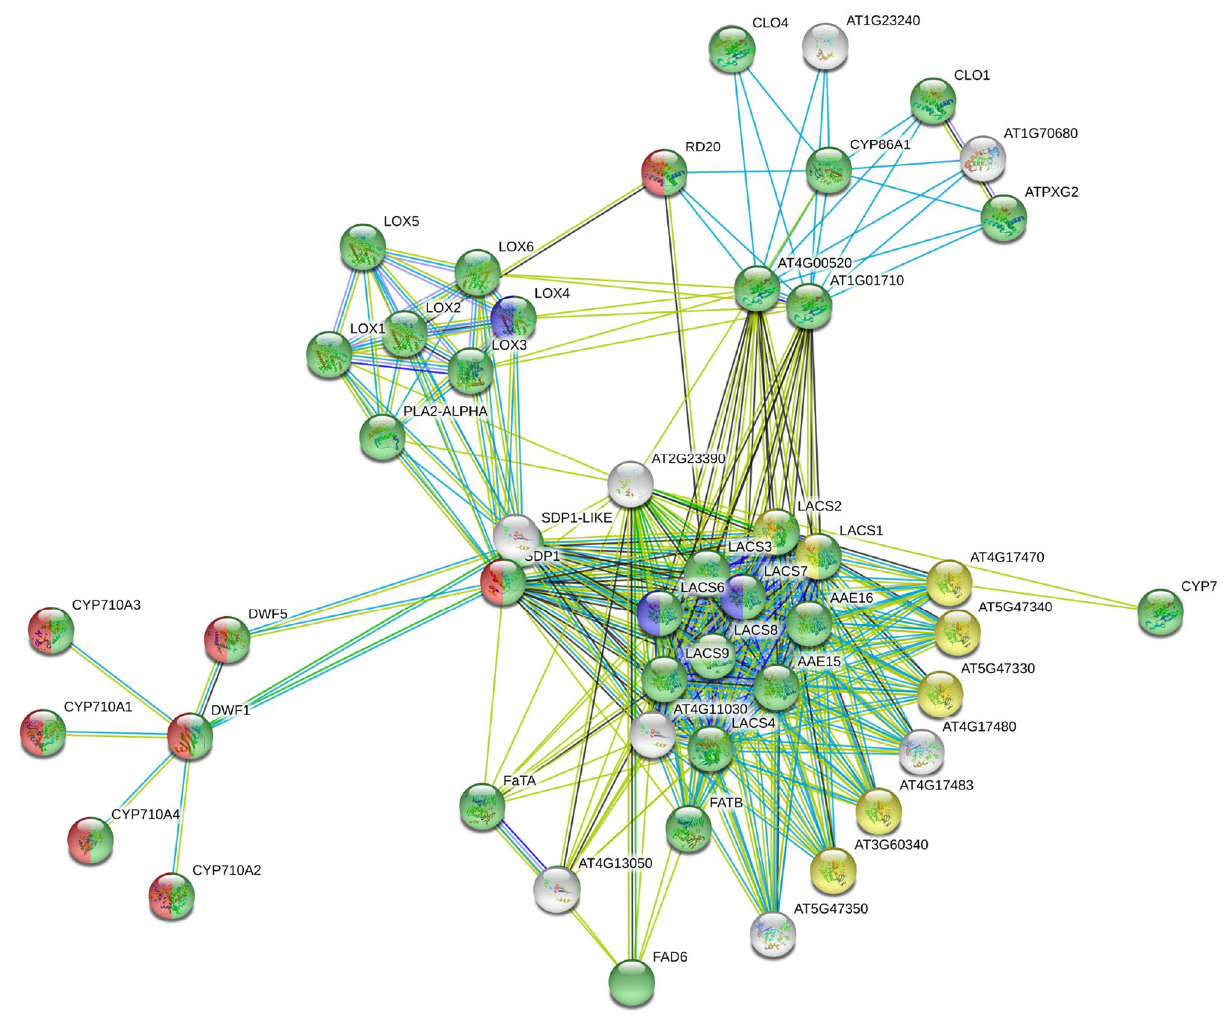
Figure 4. Interaction networks of milk thistle genes. Genes (nodes) with same color activate in the same pathway. Lines between genes indicate the interaction between according to lipid network classification (Fig. 5). There was a correlation between genes and the lipids network, and so, lipid pathways interacted with their biosynthesis genes. The biggest group with maximum number of genes, group 1 (green), included LOX , LACS , AAE , FAT , CYP , DWF and CLO families, as well as FAD6 , SDP1 , ATPX62 , RD20 , PLA‑ALPHA , AT1G05790 , AT4G00520 and AT1G01710 genes, which led to the biosynthesis of stearic acid, oleic acid, palmitic acid, linoleic acid, cholesterol, β-Sitosterol, β-Monolinolein, linoleic acid ethyl ester and 1-oleyl glycerol. This group of genes is involved in the biosynthetic and metabolic processes of fatty acids, lipids, cellular lipids, small molecules, oxoacid, oxylipin, organic acids, carboxylic acid, monocarboxylic acid, as well as reductions in oxidation, oxidation and modification of lipid, finally, it is involved in the meta- bolic process of long-chain fatty acid and lateral root formation. Group 2 with red colors comprised CYP710A1 , CYP710A2 , CYP710A3 , CYP710A4 , DWF1 , DWF5 , SDP1 and RD20 , which were involved in biosynthesis of cholesterol and β-Sitosterol and organic compounds. Depalmitoylation and deacylation of macromolecules is performed by genes in group3 (yellow), which include LACS1 , LACS2 , AT4G17470 , AT5G47340 , AT5G47330 , AT4G17483 and AT3G60340 were categorized into group 3, yellow colors, which were active in palmitic acid and linoleic acid ethyl ester biosynthesis pathway. Group 4 with blue colors contained LACS6 , LACS7 and LOX4 , which engaged in biosynthesis pathway of palmitic acid and linoleic acid play role in the response to ozone. After comparing protein and metabolite networks, 4 up- and 4 down-regulated genes with high interaction was chosen (Fig. 4). Given that CYP86A1 , CYP710A1 , FATA2 , LACS3 , LOX2 , Palmitoyl-protein thioesterase ( PAL ), PLA2‑ALPHA and PXG3 genes were not previously identified in the plant of our interest, so, the nucleotide sequence of these genes (based on our RNA-Seq data in previous research) was provided to submit in NCBI data- base. Accession numbers of selected genes are MW151571, MW151572, MW151573, MW151574, MW151575, MW151576, MW151577 and MW151578, respectively.